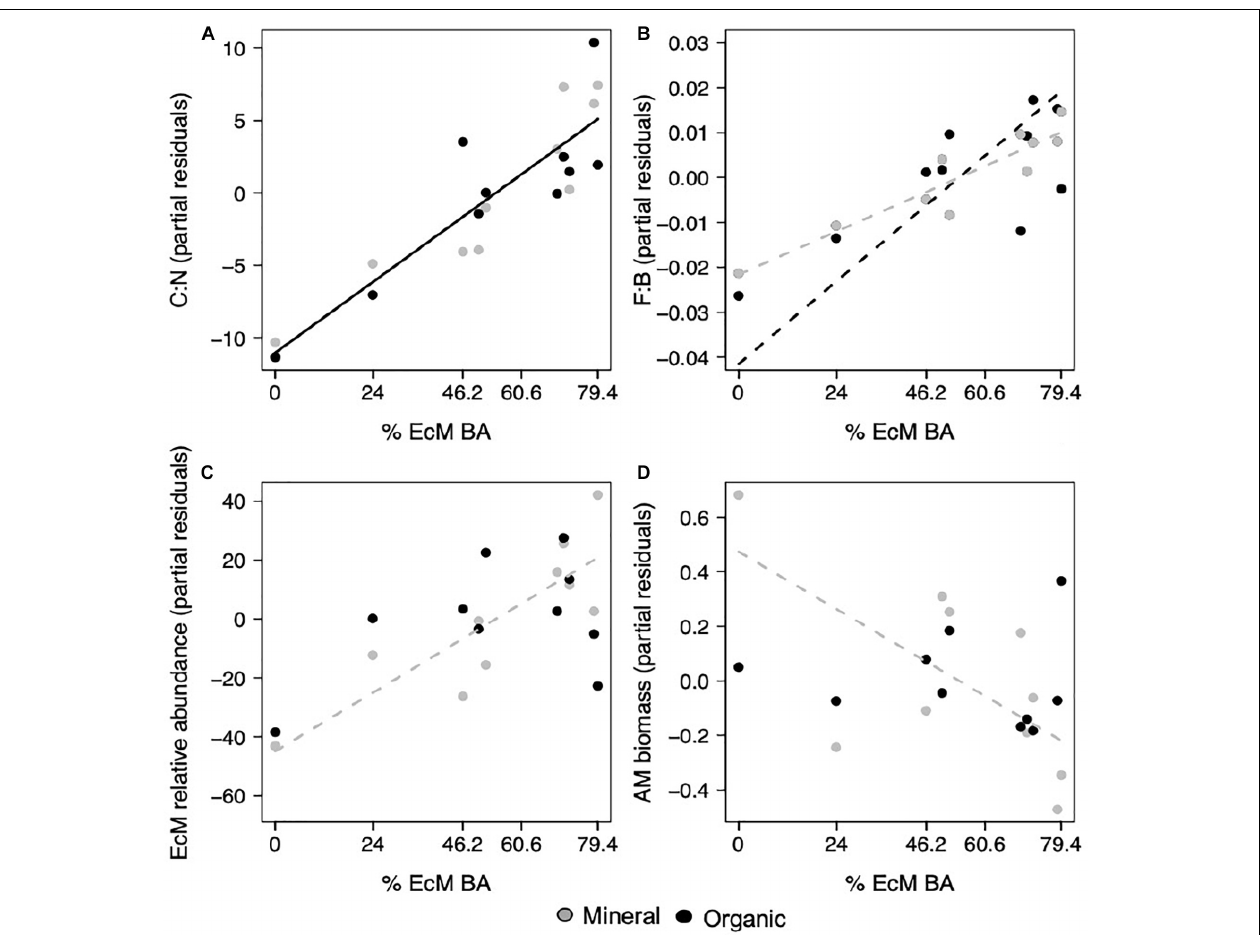
FIGURE 1 | With increasing percent EcM basal area in sample plots, (A) the carbon to nitrogen ratio increased in both horizons, (B) the fungal to bacterial ratio increased with a greater response in the organic relative to mineral horizon, (C) EcM relative abundance increased in the mineral horizon, and (D) AM biomass nmol g − 1 decreased in the mineral horizon. Points represent regression partial residuals. Black solid lines represent linear relationships with no horizon interaction, while dashed lines represent individual horizon responses where the mineral horizon is represented by gray and the organic horizon by black lines ( p < 0.05).